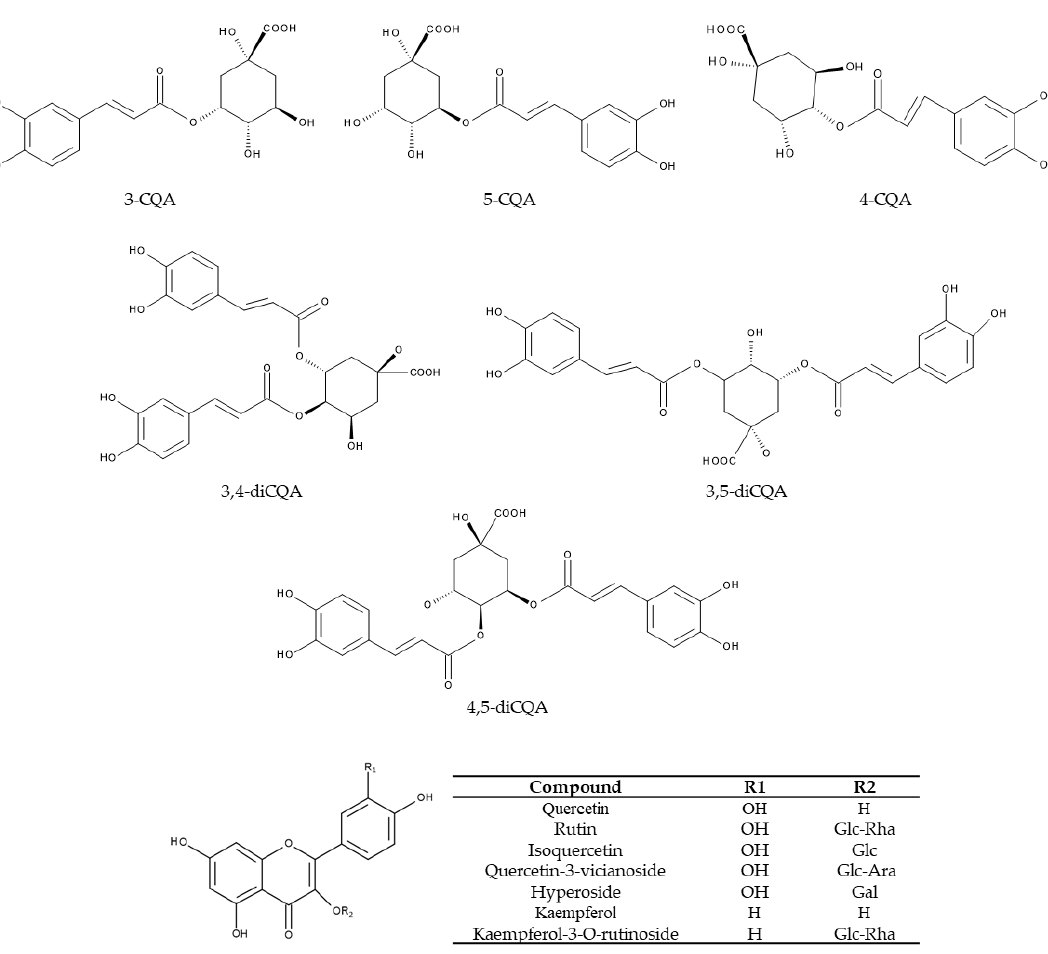
Figure 6. Chemical structures of the main polyphenols in Kuding tea. Ara, arabinoside; CQA, caffeoylquinic acid; Gal, galactose; Glc, glucoside; Rha, rhamnoside.